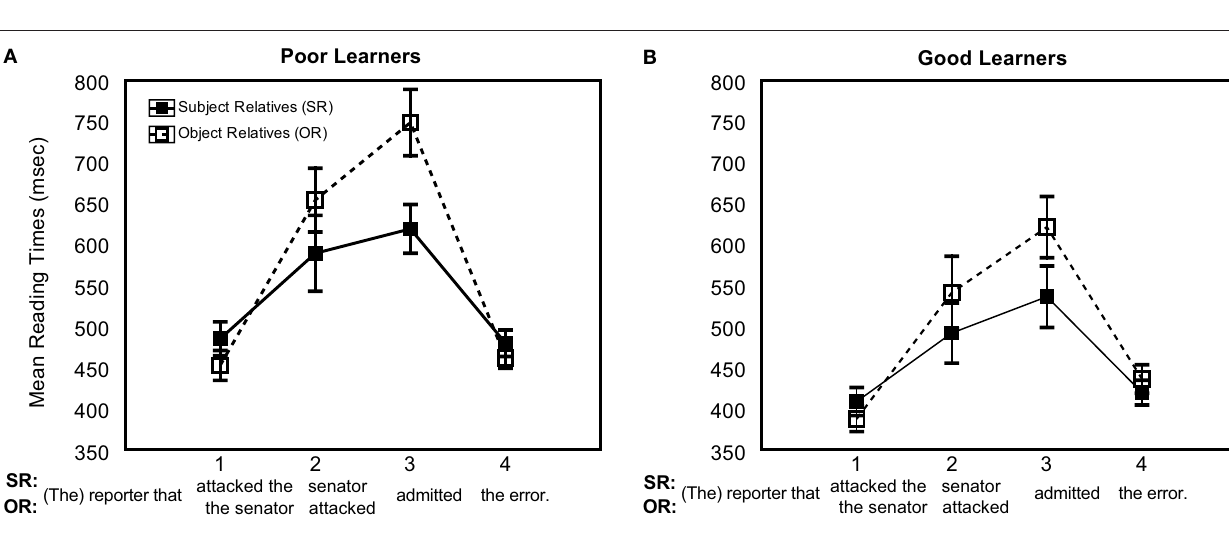
Figure 5 | reading times by sentence region of subject/object relatives for (A) poor and (B) good